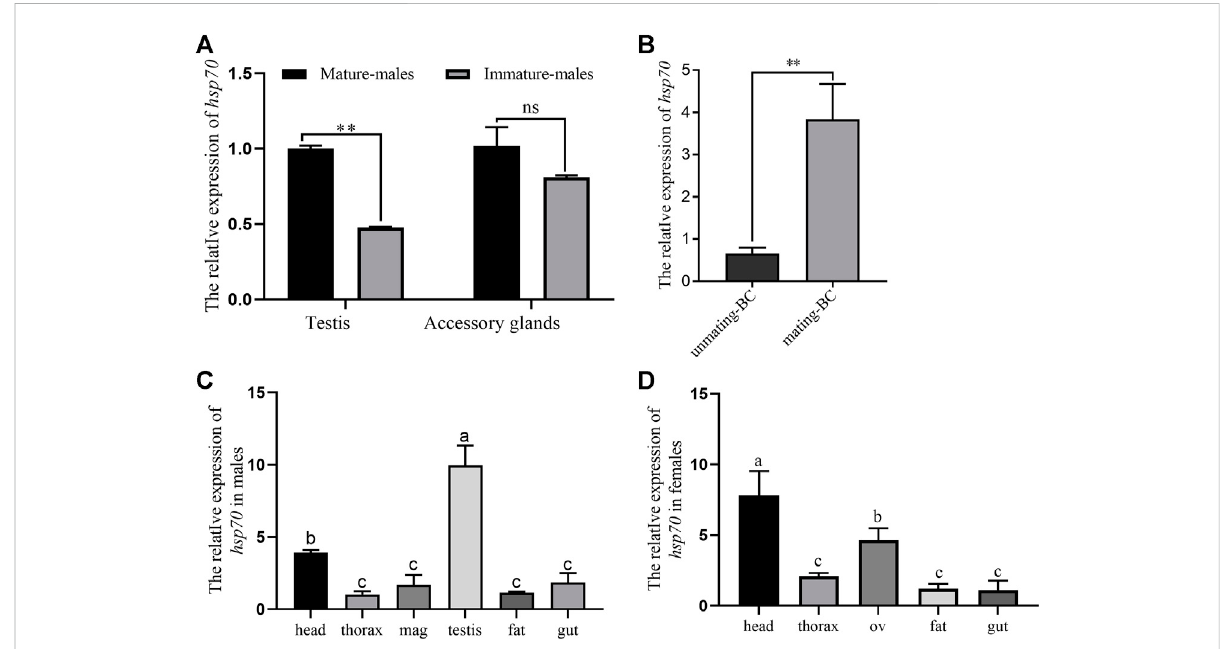
FIGURE 1 A) Expression levels of Ochsp70 in male testicular tissues; the expression patterns validation validate of the Ochsp70 transcriptome data in the male reproductive system. (B) Expression level of Ochsp70 in mating-bursa copulatrix (mating-BC) than unmating-bursa copulatrix (unmatingm- BC). (C) Expression pro fi les of Ochsp70 in different tissues of males beetles O. communa . (D) Expression pro fi les of Ochsp70 in different tissues of females beetles O. communa . Values are represent means ± SD. The data were analyzed usingby one-way ANOVA followed by the